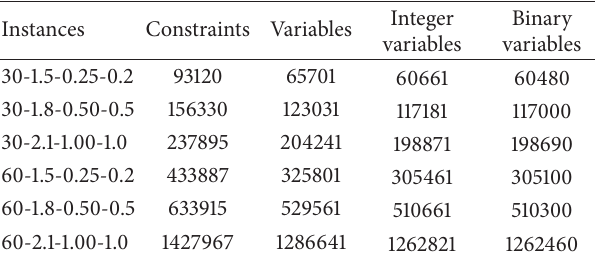
Table 3: Comparison of runtimes between models using DTRTP approach and PSSA with CPT approach.